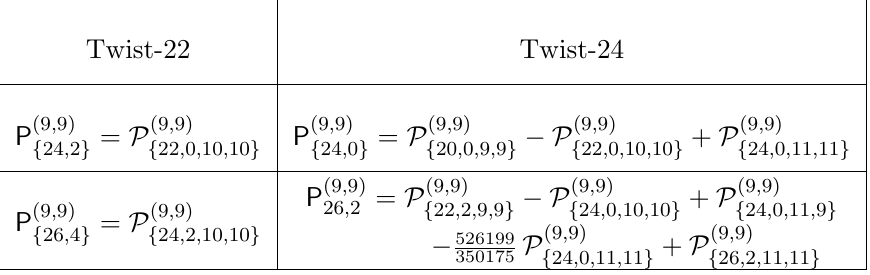
Table 6 . Decomposition of sum rules P (9 ; 9) into super-sum rules